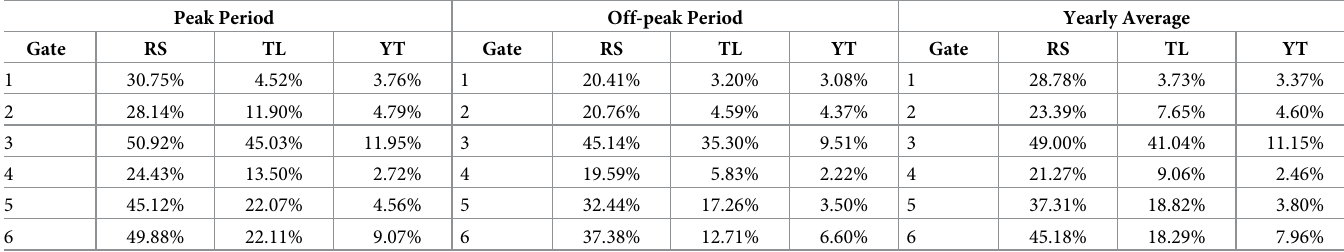
Table 7. Simulation results for scenario S1.